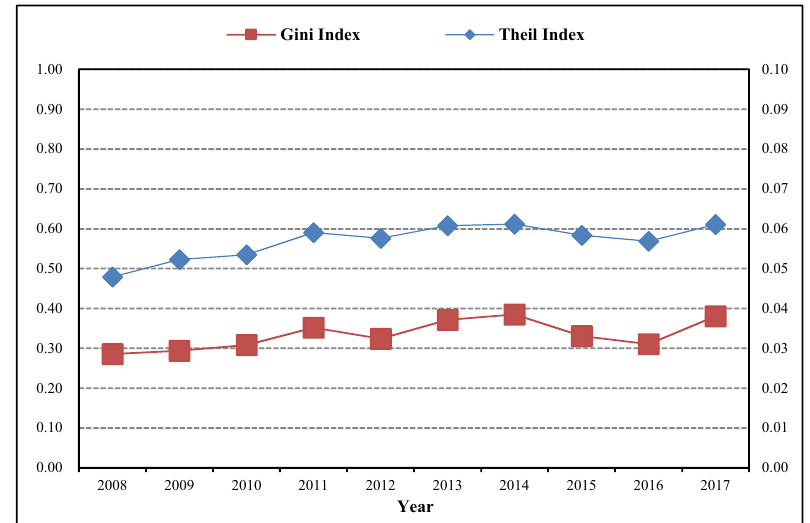
Figure 5. Total Theil index and total Gini index of regional differences in allocation efficiency of rural public health resources in China from 2008 to 2017.